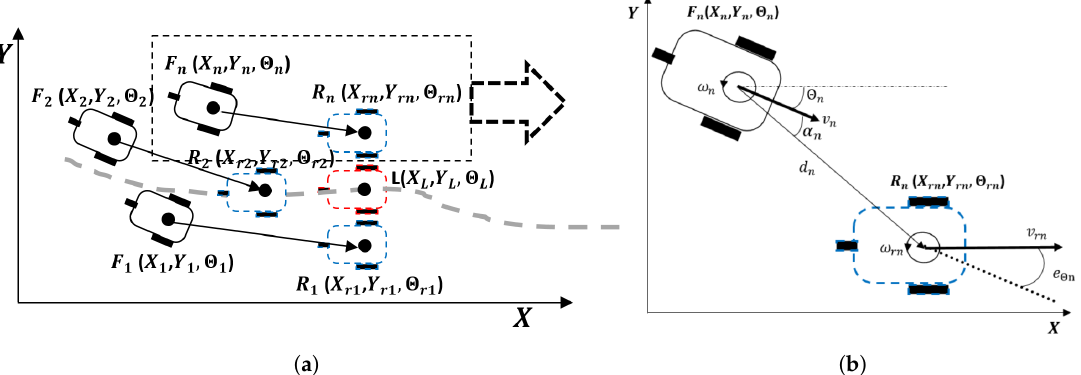
Figure 1. ( a ) main variables describing the trajectory tracking in formation strategy: in blue, the reference poses of each robot R n ( X rn , Y rn , Θ rn ) , which are generated according the position of a virtual leader robot L ( X L , Y L , Θ L ) in red and in black the current position of each robot, described by F n ( X n , Y n , Θ n ) ; ( b ) main variables describing trajectory tracking of one robot in the formation, where the robot reference is computed according to the position of the virtual leader: d n is the distance error calculated from the robot point ( X n , Y n ) to the reference point ( X rn , Y rn ) , α n is the orientation error with respect to the target point, e Θ is the orientation error between the desired orientation to follow n the trajectory ( Θ rn ) and the orientation of the robot ( Θ n